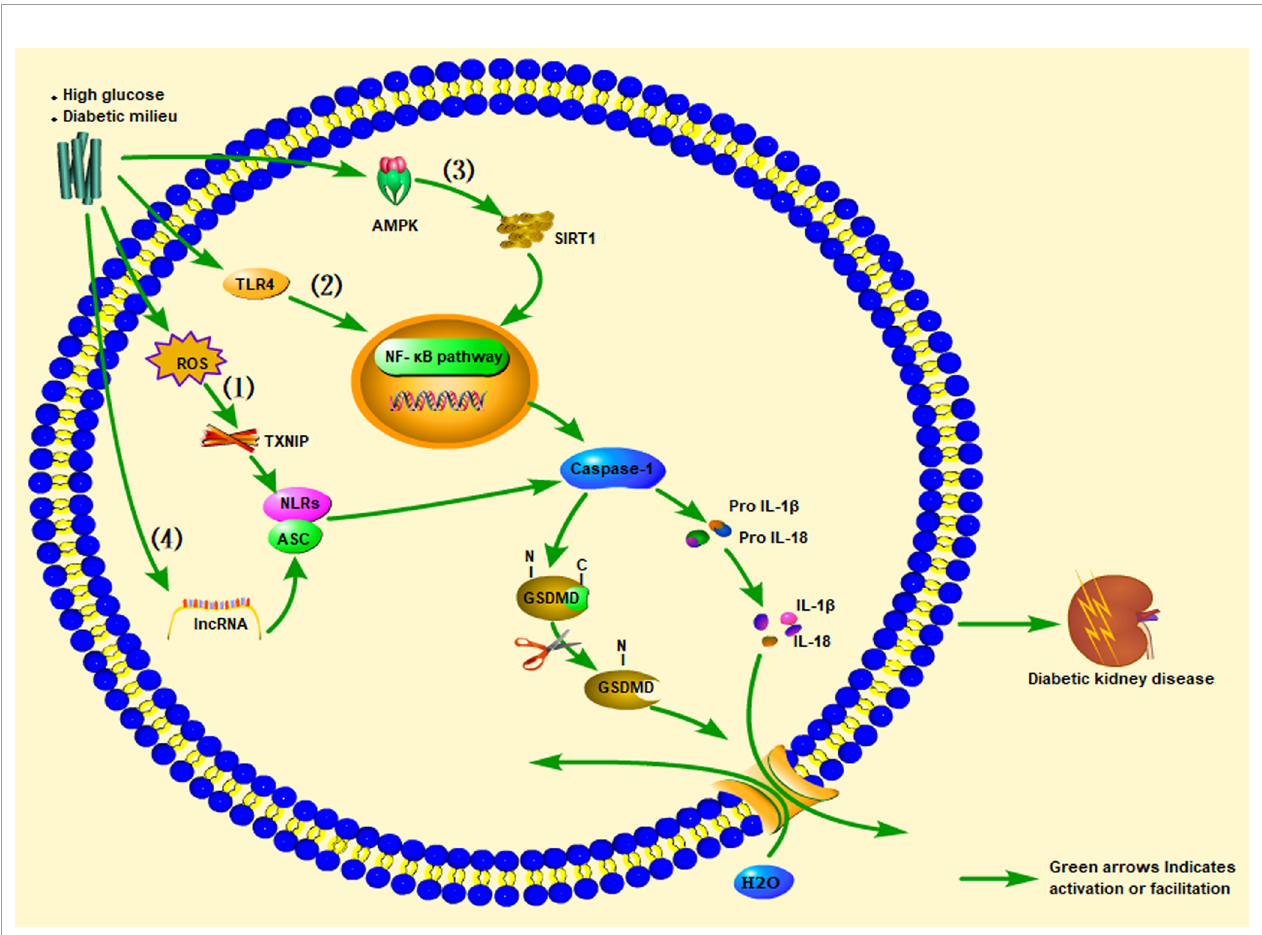
FIGURE 2 | Promotion of in fl ammasome pathways associated with pyroptosis of cells in the kidney (glomerular endothelial cells, tubular epithelial cells, podocytes, tubular epithelial cells) under high-sugar or diabetes conditions, leading to diabetic kidney disease (DKD). In renal cells stimulated by high glucose (HG): (1) ROS/ TXNIP/NLRP3 in fl ammasome signaling pathway, (2) TLR4/NF- k B in fl ammasome signaling pathway, (3) AMPK/SIRT1/NF- k B in fl ammasome signaling pathway, or (4) lncRNA)-related signaling pathways, they all activate pro-caspase-1 to become mature caspase-1. Caspase-1 cleaves GSDMD and activates the inactive pro IL-1 b and pro-IL-18 to become mature IL-1 b and IL-18, and the released GSDMD-NT forms a pore in the cell membrane, ultimately leading to DKD. ROS, Reactive oxygen species; TXNIP, Thioredoxin-interacting protein; AMPK, Adenosine 5 ’ -monophosphate (AMP)-activated protein kinase; SIRT1, Silent information regulation 2 homolog1; NF- k B, Nuclear factor